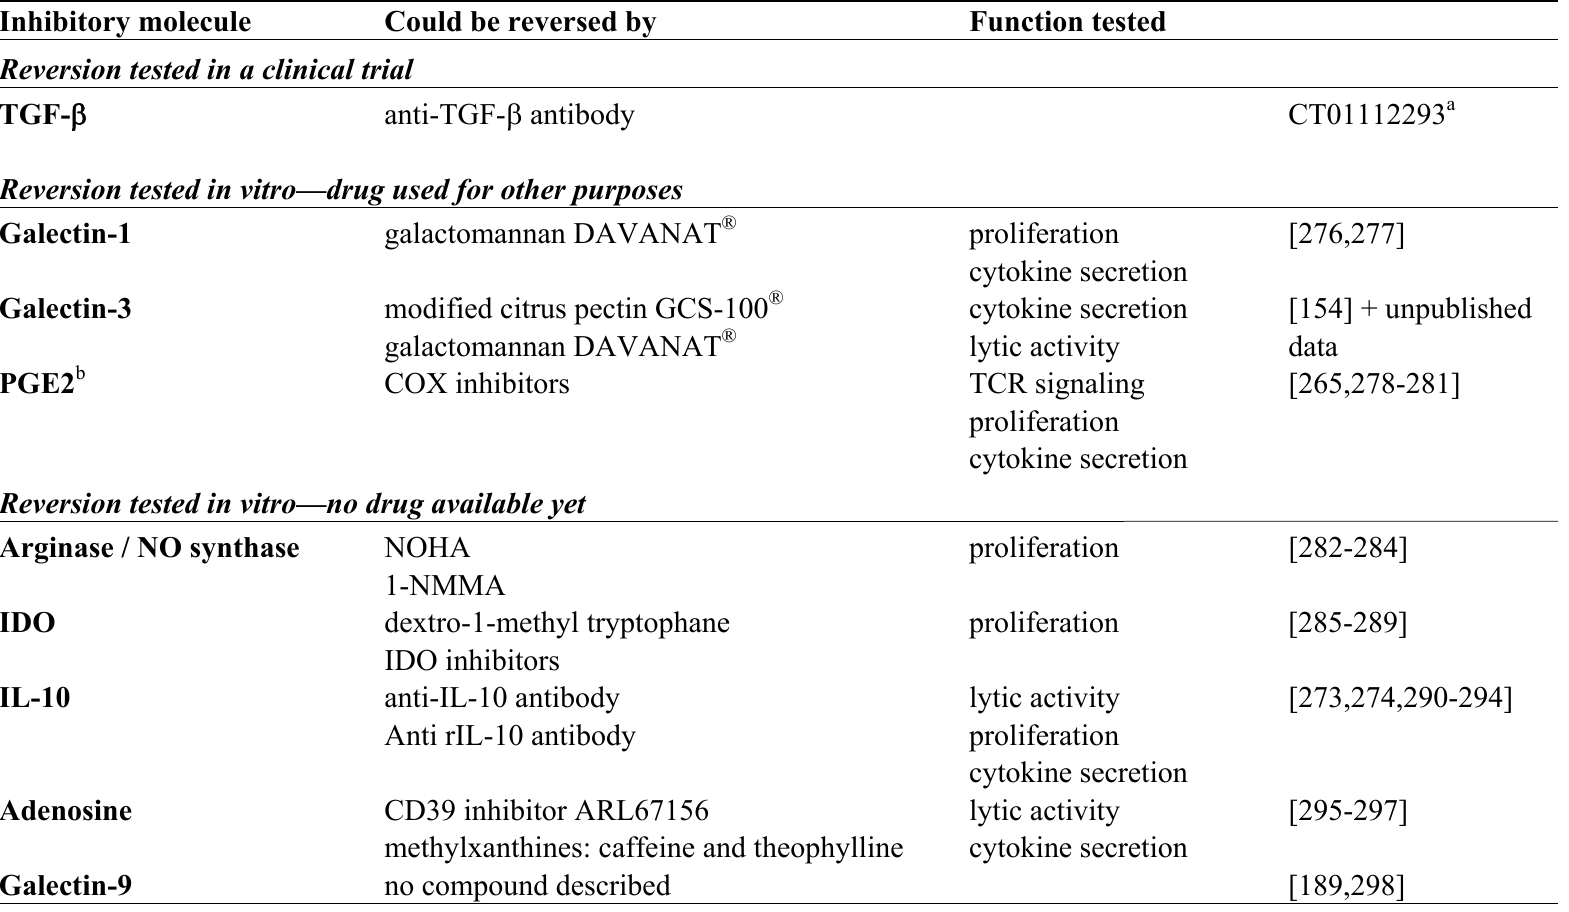
Table 4. Soluble molecules with a suppressive activity on TIL and counteracting